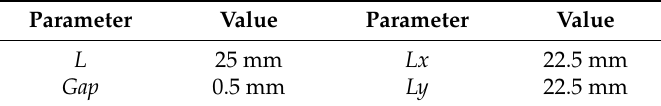
Table 1. Parameters of the 1-bit digital RRM element.